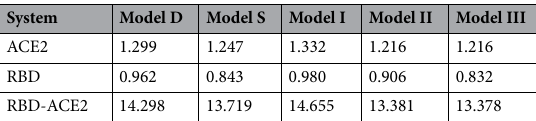
Table 1. Average RMSF of interafce residues.